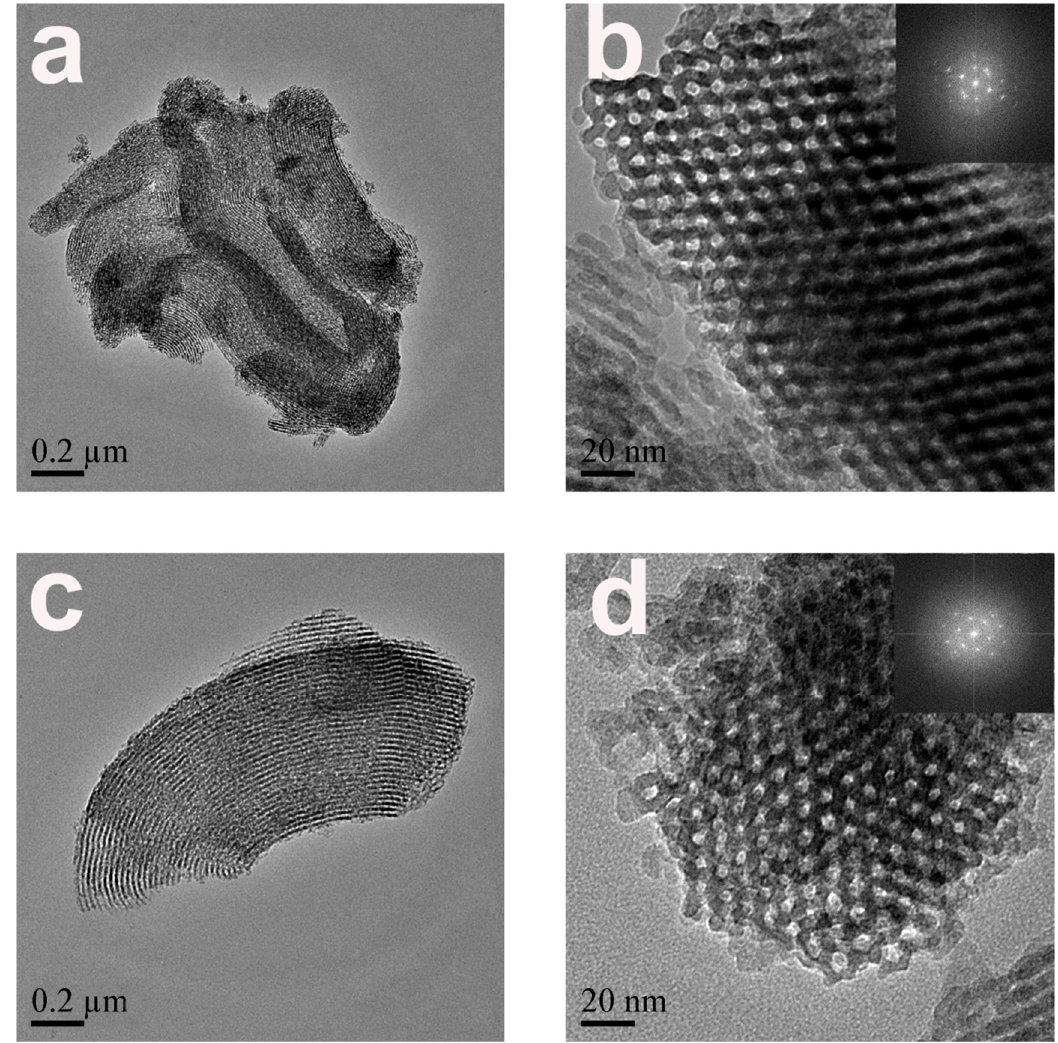
Figure 2. TEM images of ( a , b ) pristine SBA-15 and ( c , d ) remnant of calcined CM-Ca2-SBA(30%). Table 1. The specific surface area, pore diameter and pore volume analysis of particles.